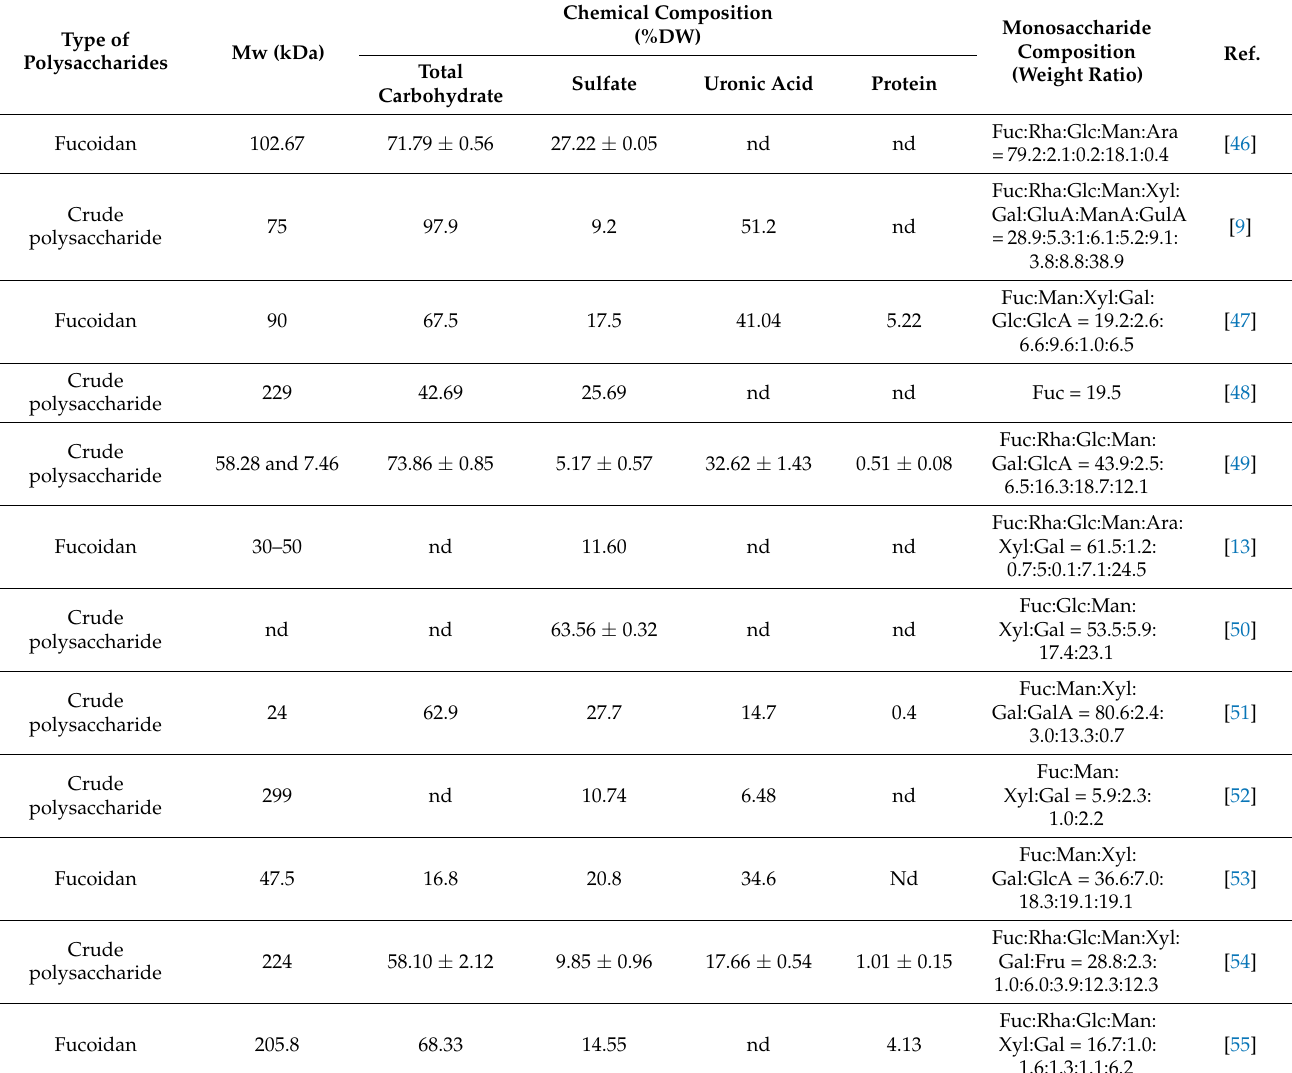
Table 3. The polysaccharide profile of H. fusiformis